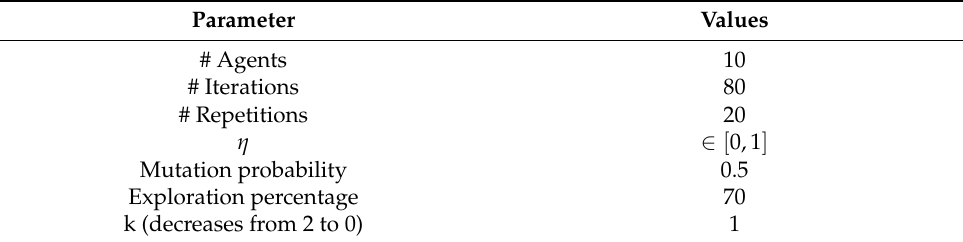
Table 1. Configuration parameters of GABER algorithm.